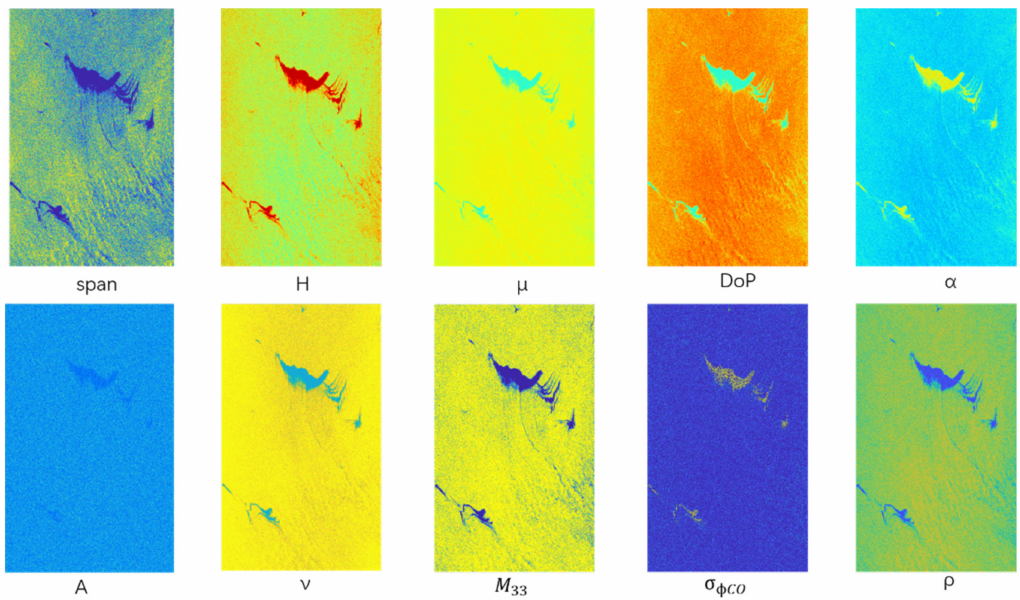
Figure 4. Presentation of ten prominent polarimetric features of image 1 by PolSARpro software and MATLAB.